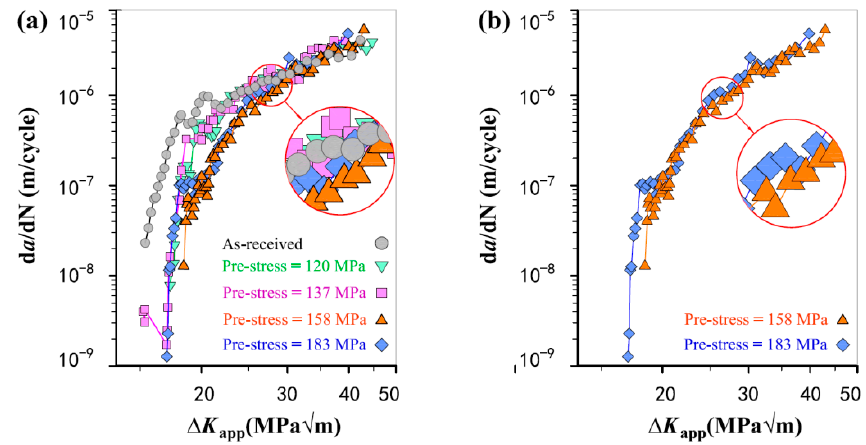
Figure 3. The da/dN- Δ K app curves for the comparison between the diverse pre-stress specimens and the as-received specimen: ( a ) the as-received specimen and the specimen with pre-stress = 120 MPa; ( b ) the as-received specimen and the specimen with pre-stress = 137 MPa; ( c ) the as-received specimen and the specimen with pre-stress = 158 MPa; and ( d ) the as-received specimen and the specimen with pre-stress = 183 MPa.